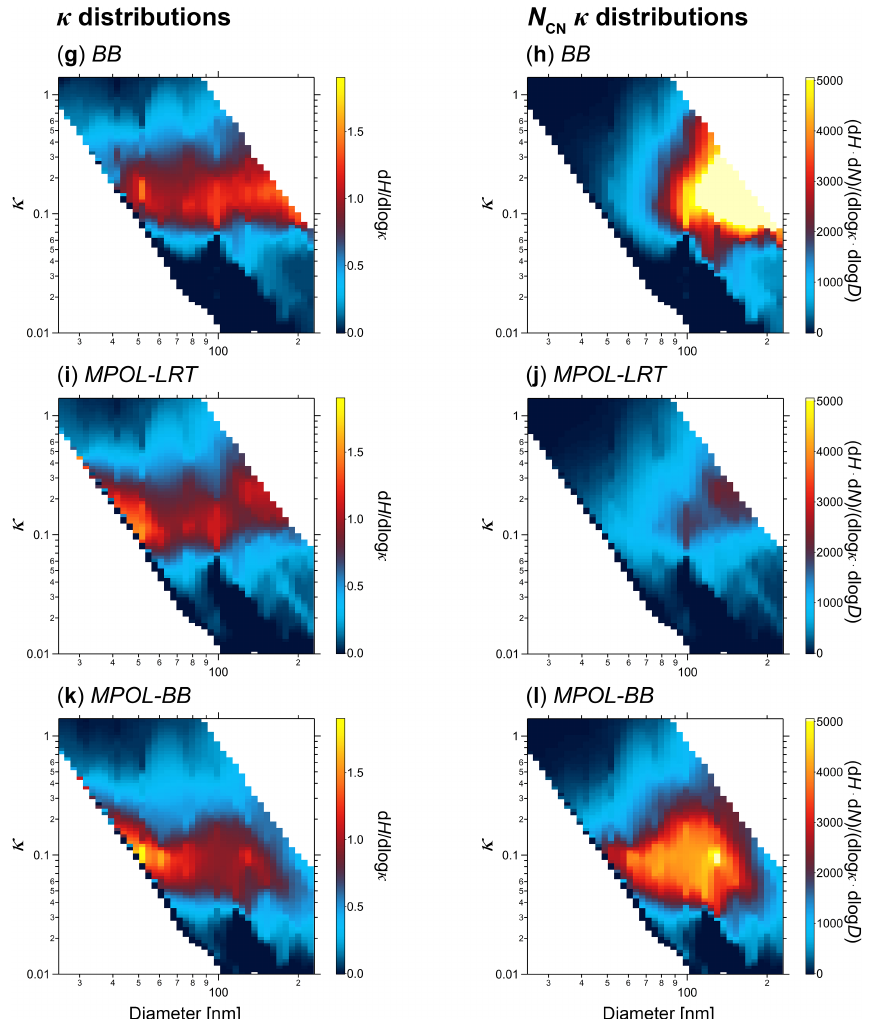
Figure 10. Average probability distribution of particle hygroscopicity, d H /dlog κ , on the left side and the same quantity weighted by the particle number size distribution, (d H · d N )/(dlog κ · dlog D ), on the right side, plotted over the effective hygroscopicity parameter, κ , and dry-particle diameter, D , for ( a and b ) the entire measurement period as well as ( c and d ) PR, ( e and f ) LRT, ( g and h ) BB, ( i and j ) MPOL-LRT, and ( k and l ) MPOL-BB conditions. The particle size distributions used for the weighting are shown in Fig.